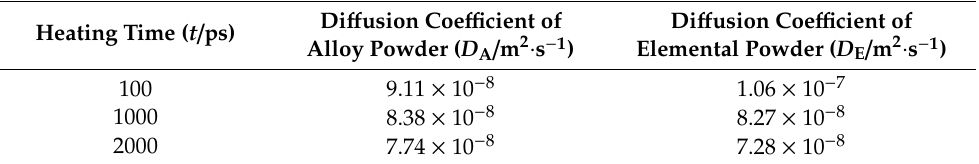
Table 2. Di ff usion coe ffi cients of alloy powder and elemental mixed powder systems for di ff erent heating